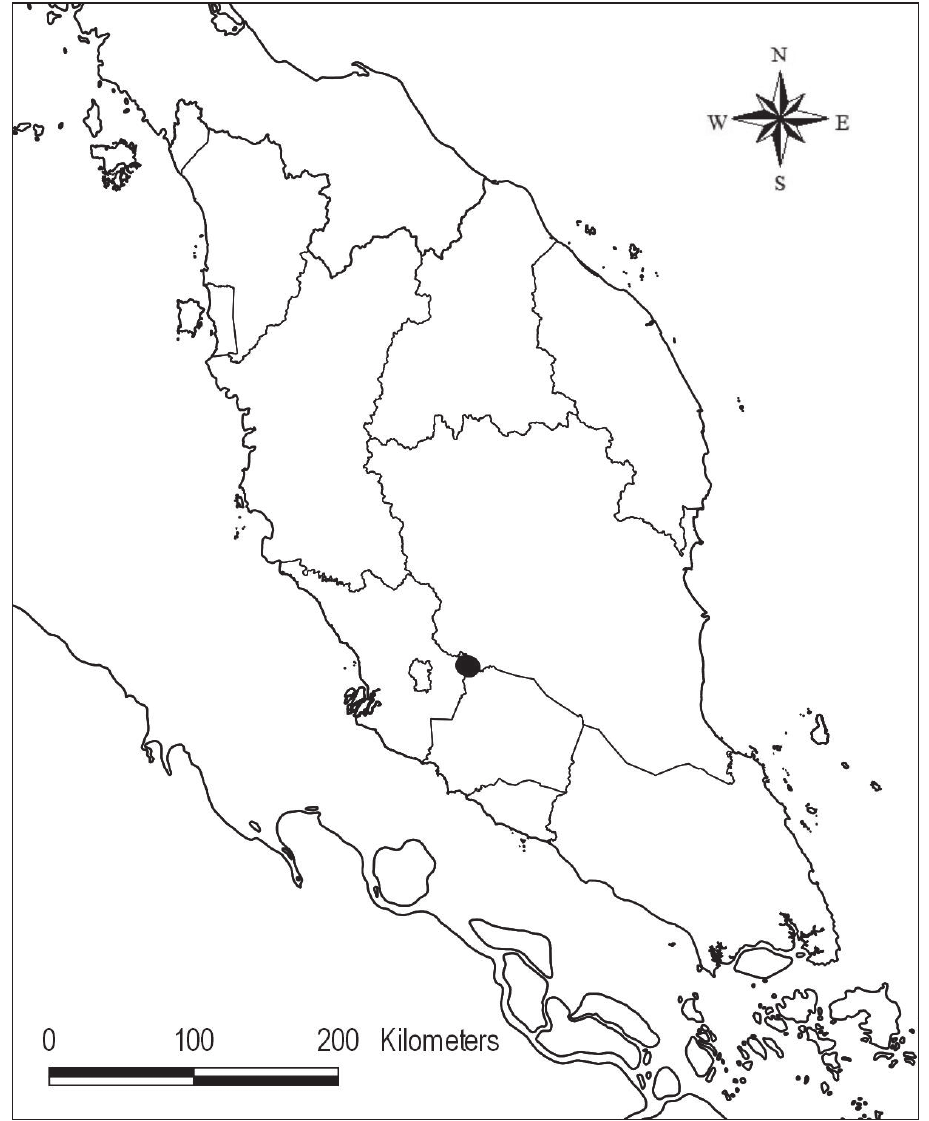
Figure 1. Distribution of Capparis kenaboiensis